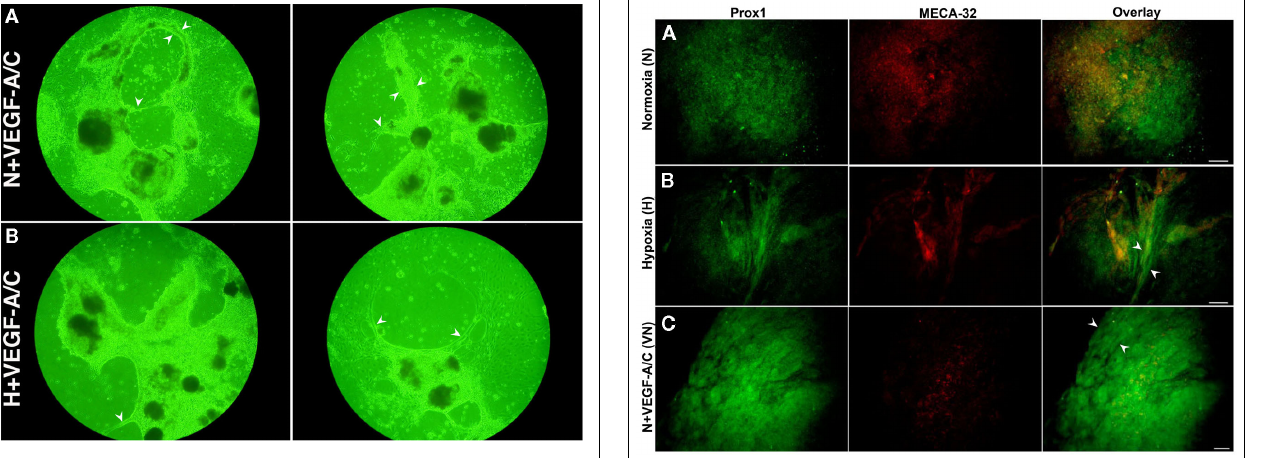
FIGURE 6 | Double immunostaining of E36.5-day-old EBs grown on collagen matrices subjected to three treatment types (N, H,VN). Representative images from three different experiments sets for each marker genes are shown. (A) Normoxic EBs exhibited similar morphology to that observed at E22.5, illustrating differentiation of both BECs (MECA-32 + ) and LECs (Prox1 + ). (B) Hypoxia alone induces some lymphatic vessel-like formation, as marked by arrowheads. (C) Normoxic EBs treated withVEGF-A/C predominantly induces lymphatic vessel-like structures (arrowheads). Images were taken at 40 × magnification (scale bar 30 μ m).